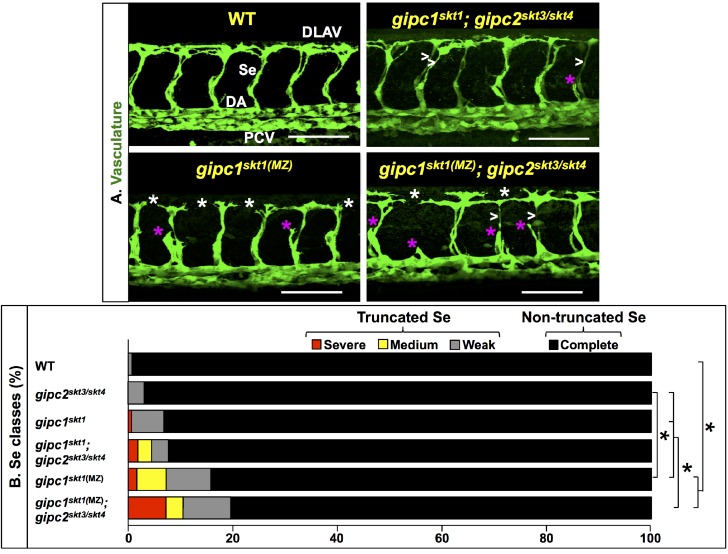
gipc mutants display angiogenesis deficits.(A) Confocal lateral images of the trunk vasculature (green) of 32 hpf embryos (region dorsal to the yolk extension). Anterior, left; dorsal, up. Scale bars (white horizontal lines), 100 μm. Genotypes indicated on top of each image in yellow font. Angiogenesis deficits are indicated as follows: white asterisks (DLAV gaps), magenta asterisks (truncated Se), white greater-than sign (thin Se). Maternal-zygotic (MZ) removal of gipc activity is denoted by the designation ‘MZ’ in superscript. In the WT image (top left), the vessels are designated with the white font as follows: DLAV (Dorsal Longitudinal Anastomotic Vessel), Se (Segmental Vessel), DA (Dorsal Aorta), and PCV (Posterior Cardinal Vein). (B) Bar graph. Percentage of Se in 32 hpf embryos of the indicated genotypes belonging to each of the following four phenotypic classes. Truncated: severe (includes missing Se), medium (yellow), and weak (gray). Non-truncated: complete (black). Significance values were calculated using a two-sided Fisher Exact test and significant differences (p<0.0033) assigned using a Bonferroni-type adjustment for 15 pairwise genotype comparisons (0.05/15 = 0.0033). Brackets and asterisks indicate pairs of genotypes with significantly different distributions of these four phenotypic classes. Quantifications. We scored Se angiogenesis in embryos of the following six genotypes: WT (138 Se, 12 embryos; an average of 11.5 Se/embryo), gipc1skt1 (130 Se, 11 embryos; an average of 11.8 Se/embryo), gipc1skt1(MZ) (380 Se, 33 embryos; an average of 11.5 Se/embryo), gipc2skt3/skt4(130 Se, 11 embryos; an average of 11.8 Se/embryo), gipc1skt1; gipc2skt3/skt4 (152 Se, 13 embryos; an average of 11.6 Se/embryo), and gipc1skt1(MZ); gipc2skt3/skt4 (220 Se, 19 embryos; an average of 11.5 Se/embryo). For additional data, graphs, and statistical comparisons related to this figure, see Figure 4—figure supplement 2, Figure 4—figure supplement 3 and Supplementary file 5. Please note that given the use of different scales for scoring angiogenesis deficits, it is unfeasible to compare the quantifications in Figure 4 and Figure 5 directly.